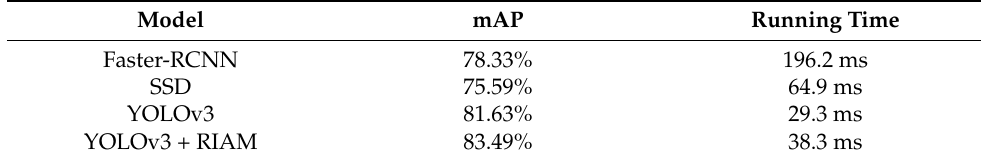
Table 1. Various neural network results.